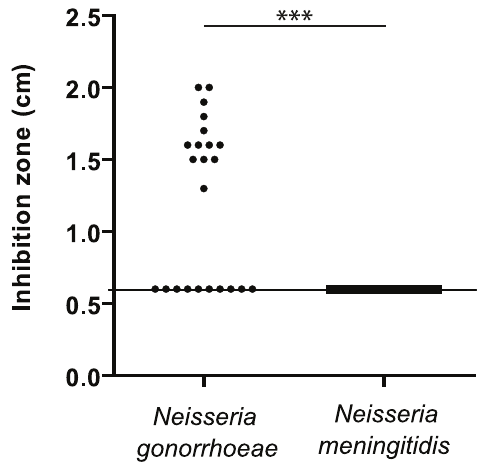
Figure 1. Resistance to manganese toxicity is a conserved trait in Meningococcus. Disk assay of the sensitivity of bacterial growth to 1M MnCl 2 in GCB agar media was carried out for several clinical isolates of N. gonorrhoeae and N. meningitidis . (*** p , 0.01)